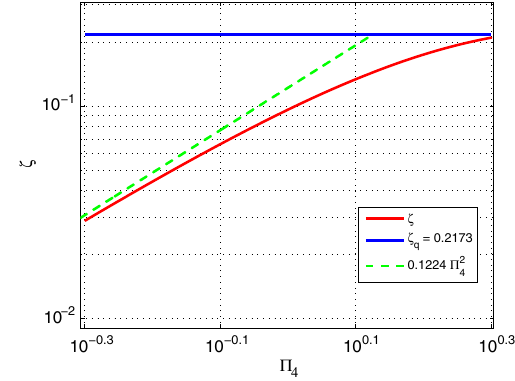
FIG. 3. ζ function as presented in Eq. (23) in the region where it cannot be approximated by one of its asymptote with less than 10% of